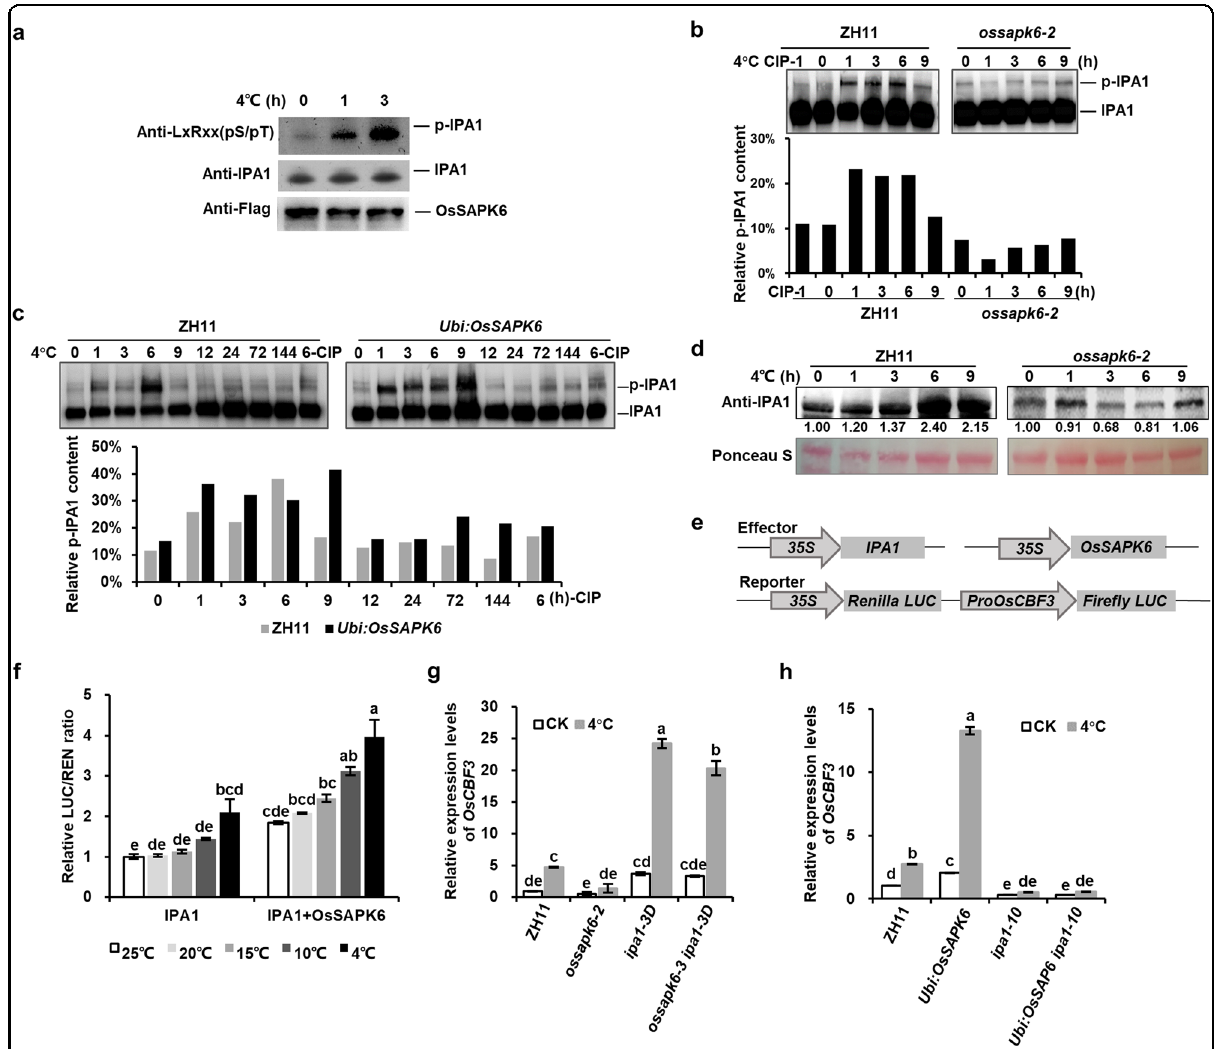
Fig. 7 OsSAPK6 phosphorylates IPA1 under chilling stress to upregulate OsCBF3 expression. a OsSAPK6 kinase activities under chilling stress. Flag-OsSAPK6 - OE transgenic seedlings were treated under 4 °C for the indicated time, and Flag-OsSAPK6 protein was then puri fi ed with anti-Flag beads, normalized, and incubated with equal amounts of puri fi ed GST-IPA1 for 30 min. The phosphorylated GST-IPA1 was detected with a polyclonal antibody against a substrate motif [LXRXX (pS/pT)], and GST-IPA1 was detected with anti-IPA1 monoclonal antibody. b Relative content of phosphorylated IPA1 in ZH11 and ossapk6-2 seedlings under chilling stress. Protein extracts from ZH11 and ossapk6-2 seedlings were separated in a Phos-tag gel, and the phosphorylated and nonphosphorylated IPA1 proteins were detected with anti-IPA1 antibody and quantitated by densitometry. c Relative content of phosphorylated IPA1 in ZH11 and OsSAPK6 -OE seedlings under chilling stress. d IPA1 protein levels in ZH11 and ossapk6-2 seedlings under chilling stress. IPA1 protein was detected by anti-IPA1 antibody. Relative amounts of proteins were determined by densitometry and normalized to loadings determined by Ponceau staining (red). e Schematics of constructs used for transcriptional activity assays in rice protoplasts. f Transcriptional activity assay in rice protoplasts showing that IPA1-mediated activation of OsCBF3 expression was promoted by OsSAPK6 and temperature sensitive. g Expression levels of OsCBF3 in ZH11, ossapk6-2 , ipa1-3D , and ossapk6-3 ipa1-3D after 4 °C treatment for 6 h. h Expression levels of OsCBF3 gene in ZH11, Ubi:OsSAPK6 , ipa1-10 , and Ubi:OsSAPK6 ipa1-10 after 4 °C treatment for 6 h. In f – h , values are means ± SD ( n = 3 technical replicates). At least three independent experiments were performed with similar results. Different letters indicate signi fi cant differences ( P < 0.01) according to Tukey ’ s HSD test. See also Supplementary Figs. S11 –